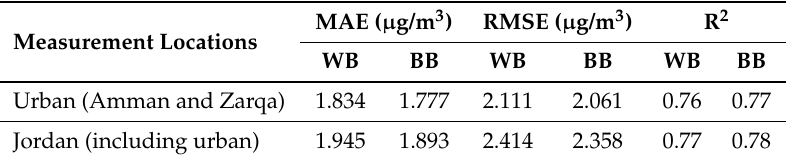
Table 3. Mean absolute error (MAE), root mean squared error (RMSE), and coefficient of determination (R 2 ) of the proposed BC proxies evaluated on BC measured at urban areas across Jordan.